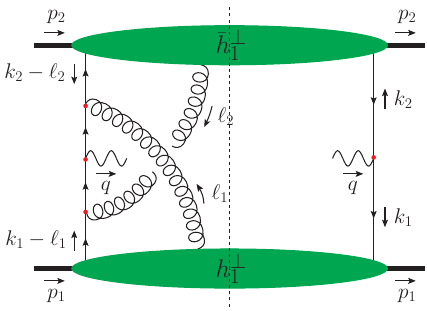
Figure 2: An example of a lowest-order graph that gives a non-zero contribution to the dBM term in the DY cross section. For convenience we have suppressed the final-state